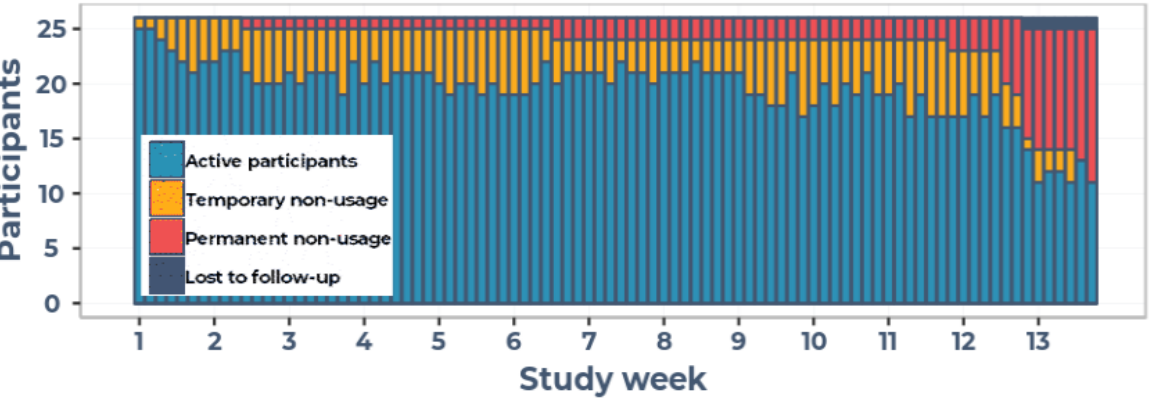
Figure 2. Active participants (blue) per study day, participants temporary nonusage (yellow), permanent nonusage (red) or lost to follow-up (dark